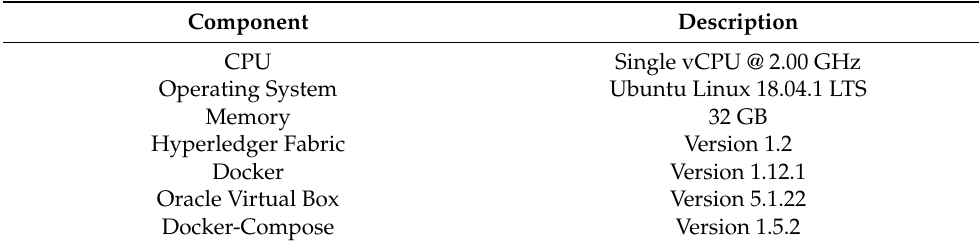
Table 2. Implementation Development